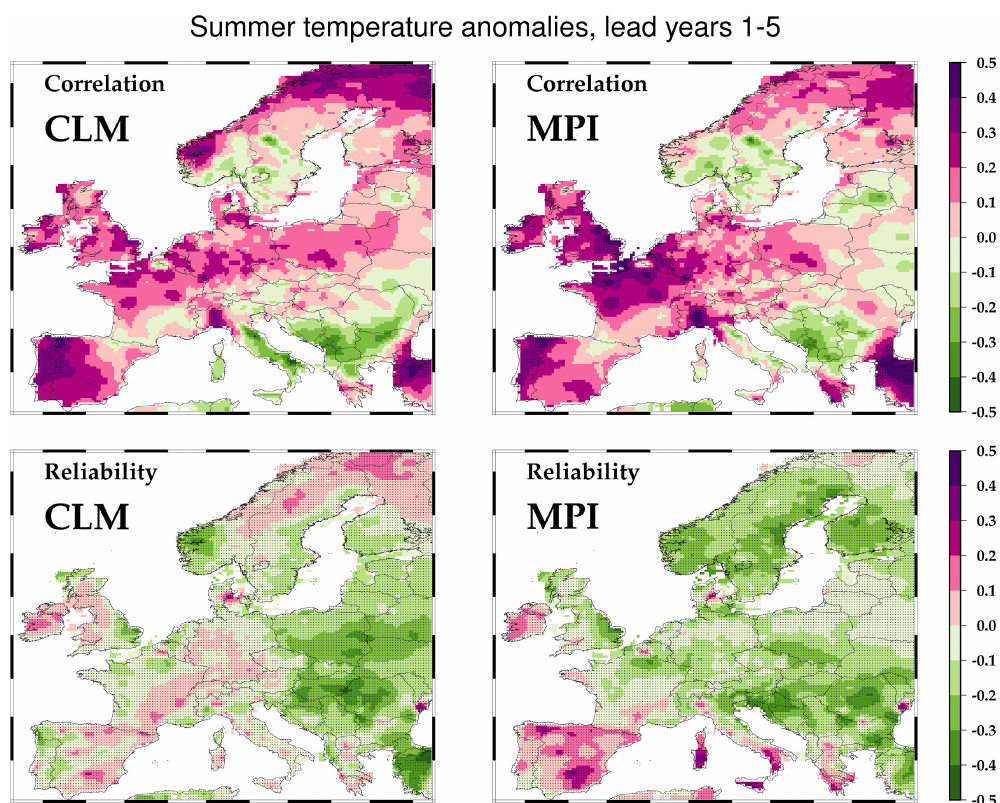
Figure 9. Summer half-year temperature anomaly means for lead years 1–5 from 1961 to 2010. The top panels show the correlation coeffi- cient between E-OBS observations and CCLM (left) and MPI-ESM-LR (right). The bottom panels show the reliability of the CCLM (left) and MPI-ESM-LR (right) ensembles with respect to the E-OBS observations. Stippling indicates results, significant at the 10% level.